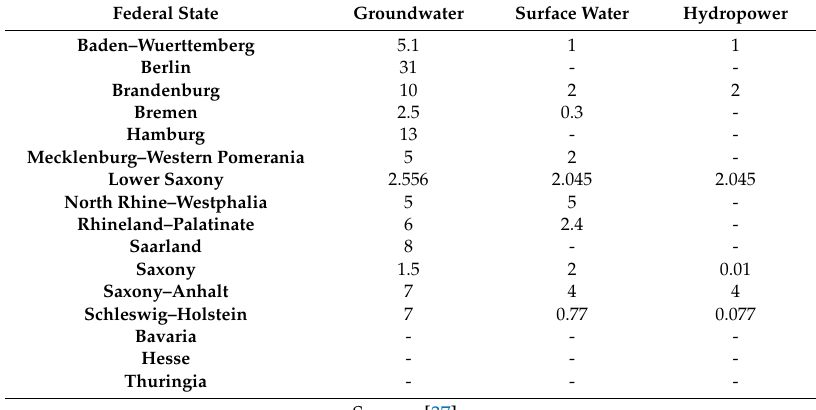
Table A2. Water extraction fees in Germany for ground- and surface waters and hydropower applications, by federal state (incl. North-Rhine Westphalia) ( € / 1000 m 3 ).